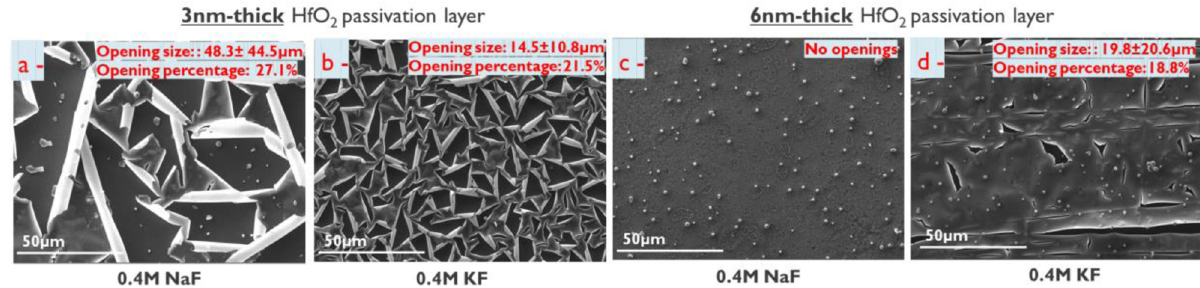
Fig. 2. SEM pictures of the test samples, (a) 3 nm thick HfO x and (c) 6 nm thick HfO x with 0.4M NaF, (b) 3nm thick HfO x and (d) 6 nm thick HfO x with 0.4 M KF solution. The opening sizes and areas were calculated via Gwyddion [9] (Magni fi cation: 800 (cid:3)